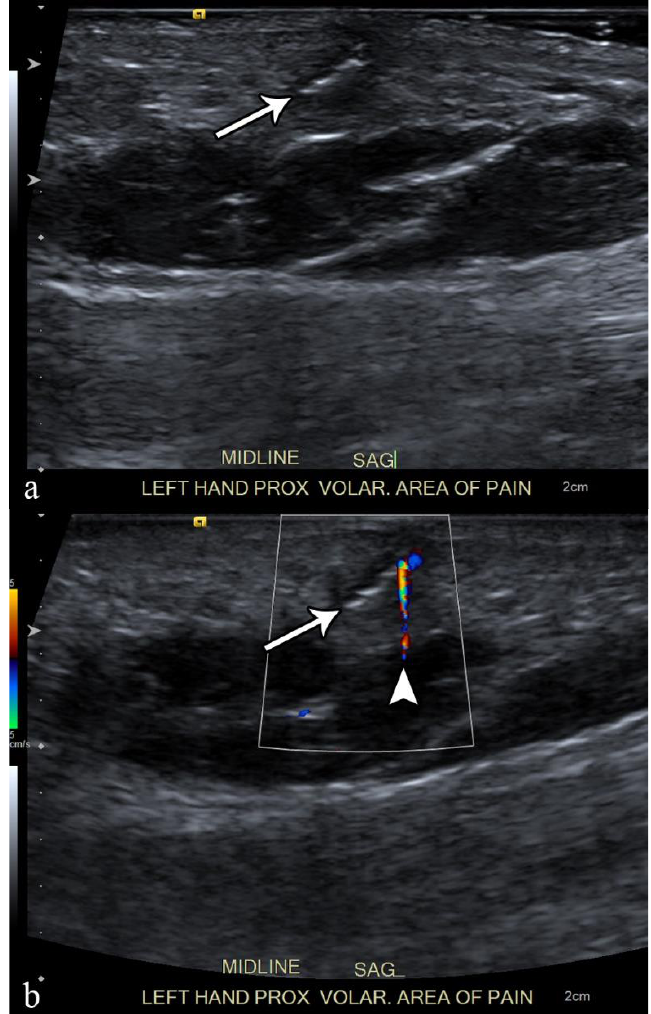
Figure 3. A 50-year-old man with left volar mid-palm pain after recent injury by glass. Grayscale US ( a ) demonstrates a 4 mm linear echogenic retained foreign body (arrows), with a surrounding hypoechoic halo (foreign body reaction/granuloma) in the subcutaneous tissues, and a color comet- tail artifact (arrowhead) on color Doppler ( b ).